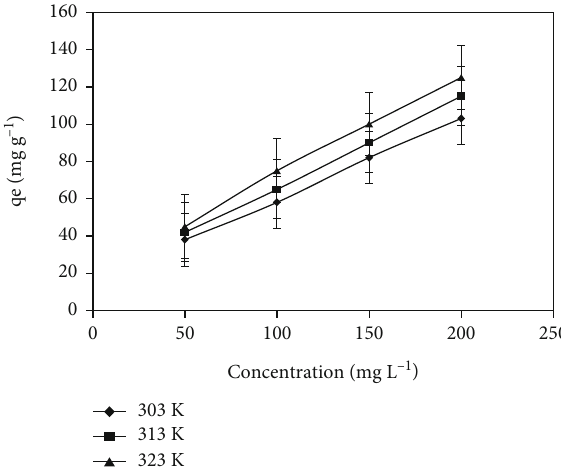
Figure 7: Graph of temperature e ff ect on PSS (adsorbent dose: 0.05gL -1 ; room temperature; and contact time: